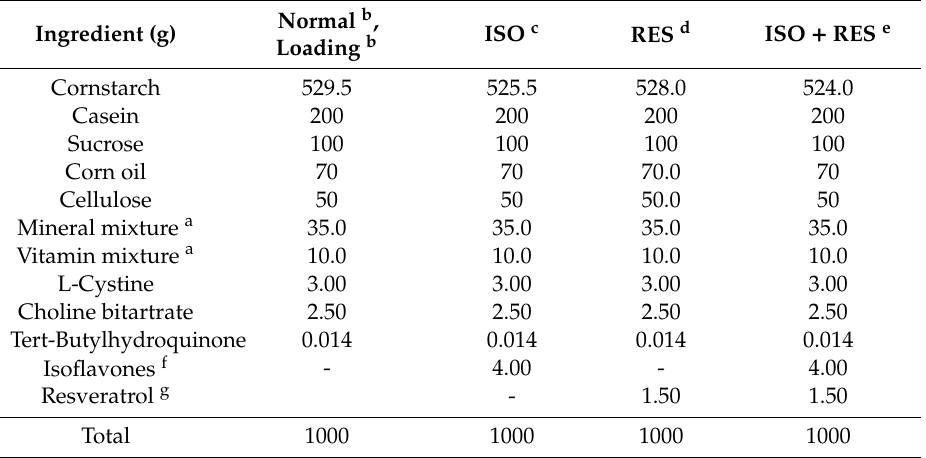
Table 1. Composition of the experimental diets a